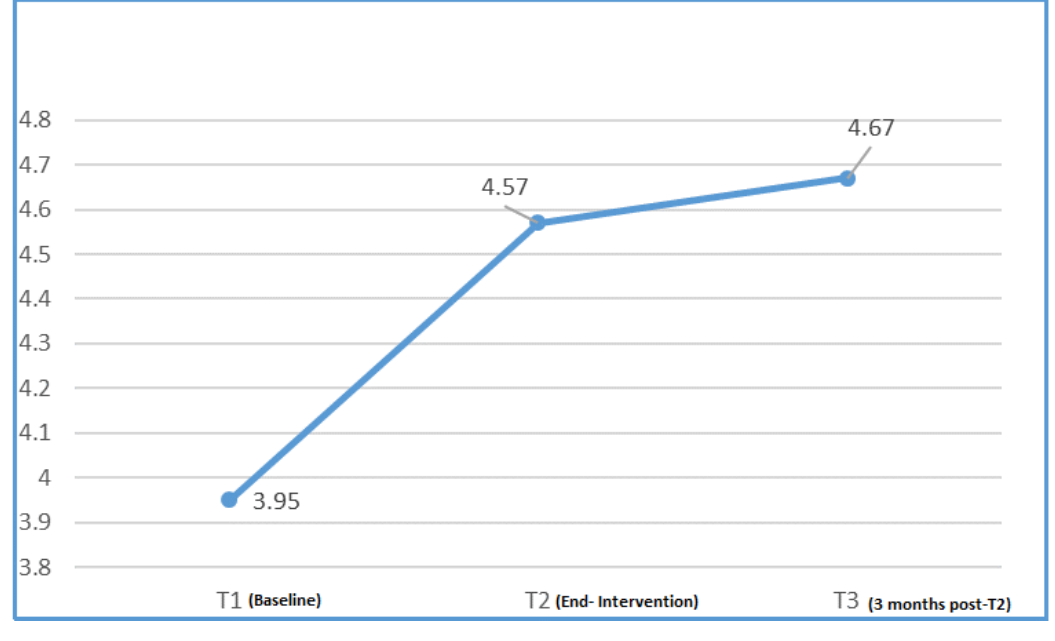
Figure 5. Changes in mean total diabetes empowerment scale (DES) scores.